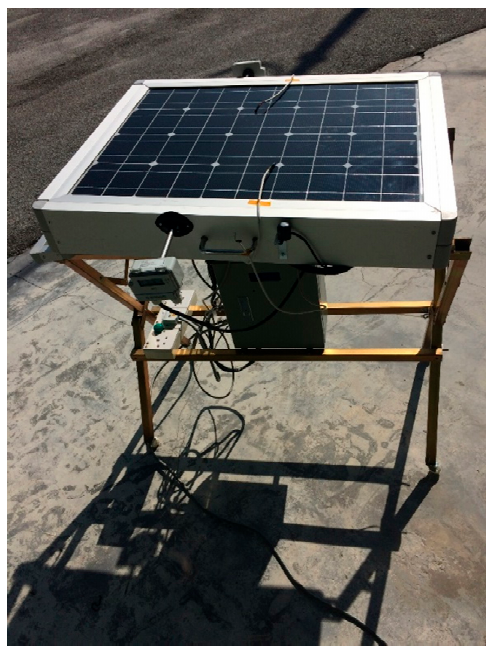
Figure 5. Experiment set-up for data collection of the PV/T solar collector.